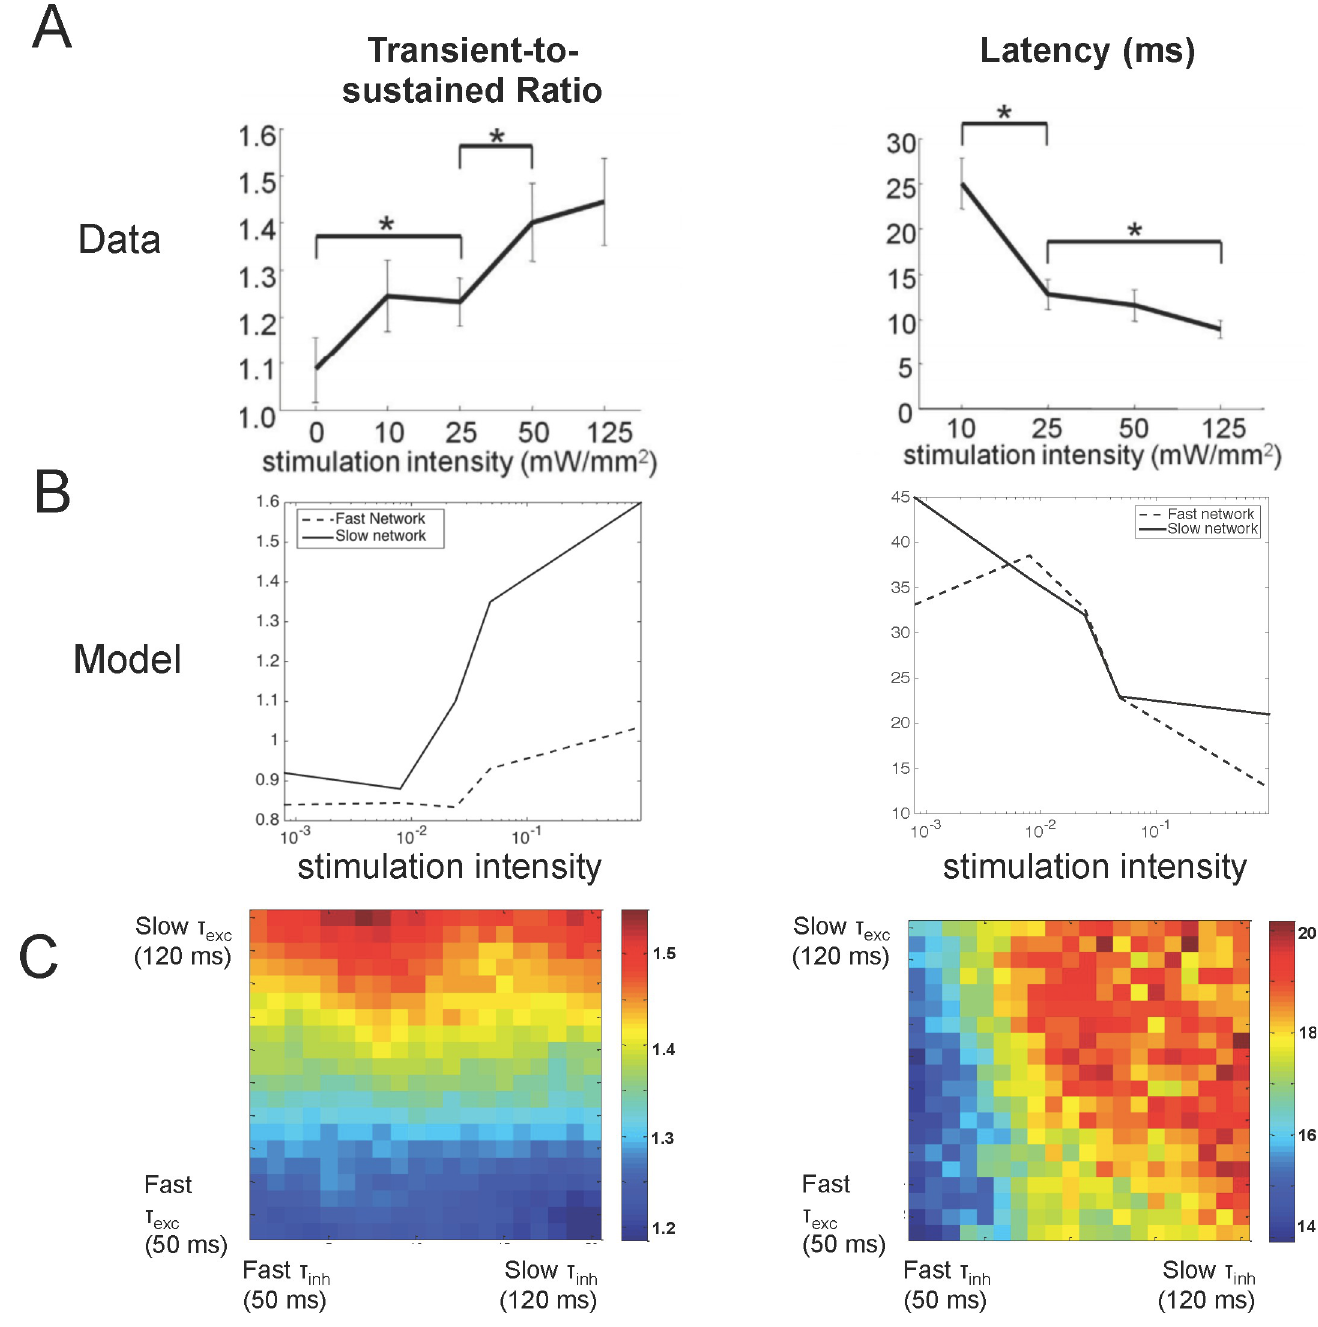
Fig 5. Intensity and synaptic-dependent changes in latencies and transient-to-sustained ratios. A) In the macaque, the ratio of the transient peak to sustained response increased as a function of laser intensity (left) and latency of neuronal responses decreased (right). B) The model that incorporated slow synapses also showed an increase in the transient to sustained ratio as a function of stimulation intensity (left), consistent with the results in the macaque. The model with fast synapses, however, could not faithfully reproduce the transient to sustained ratio found in the macaque, but more accurately accounted for the decrease in latency seen with laser intensity (right). C) The model suggests that the transient-to-sustained ratio and latency are dependent upon synaptic time constants. In particular, the transient-to-sustained ratio increases as a function of the excitatory time constant (left) and the latency increases as a function of the inhibitory time constant (right). These simulations were performed at the highest simulated intensity